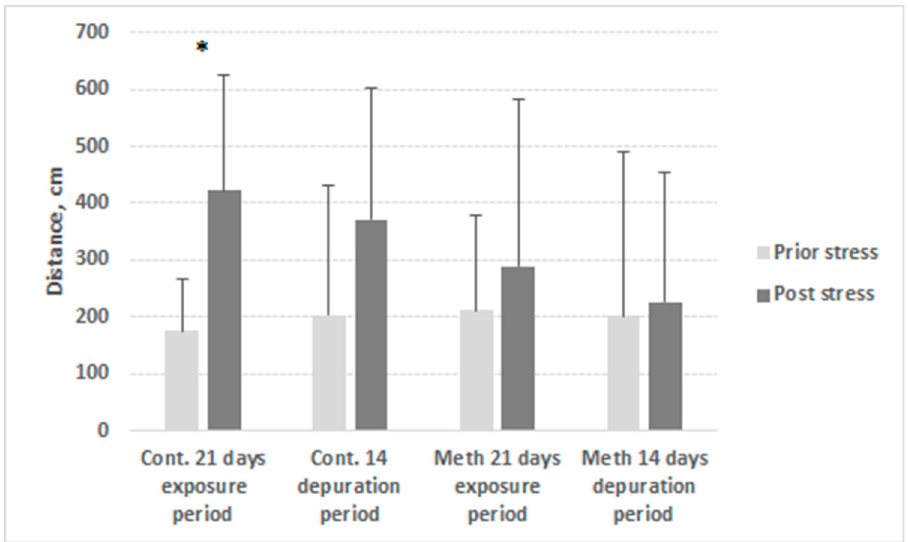
Figure 3. Mean distance moved by control (Ctr.) and METH ‐ exposed (Meth) signal crayfish during exposure and depuration (D). Before (light grey) and after (dark grey) stress application. Columns correspond to the mean results of trials conducted on days 0, 1, 7, 14, and 21 of the 21 ‐ day exposure period and on days 1, 2, 7, and 14 of the 14 ‐ day depuration period. Whiskers correspond to standard deviation; n = 12 in each trial. * indicates significant difference ( p < 0.05).